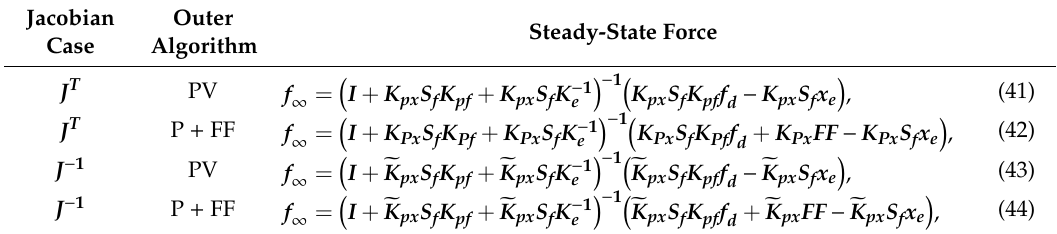
Table 2. Response force of the control force with absolute position inner